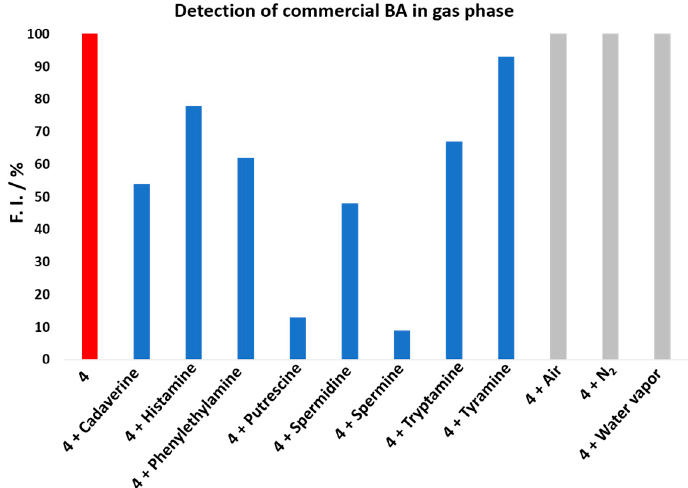
intensity variation (512, 551, and 649 nm; 574 nm, respectively). |4| = 35 µ M and λ exc = 551 nm.